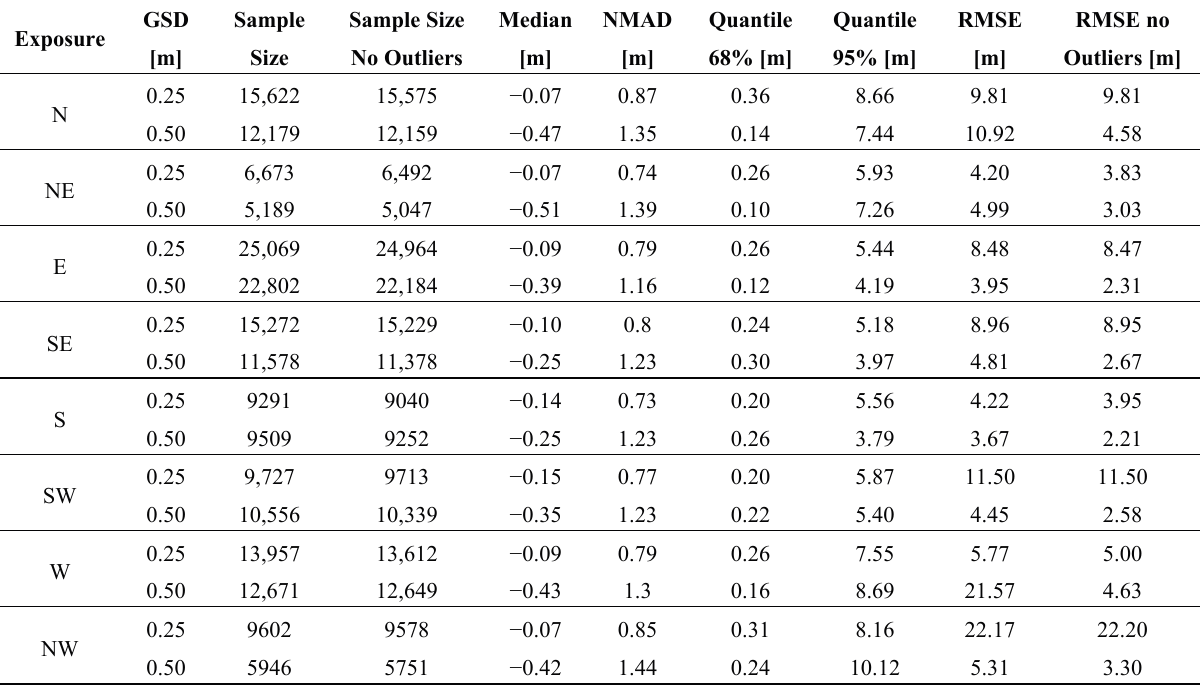
Table A4. Vertical agreement measurements of the digital surface model based on stereo measurements distinguishing eight aspect classes. Differences are calculated by subtracting the elevation values of the stereo measurements from the digital surface model values. A threshold value of ±3 × RMSE was applied for outlier